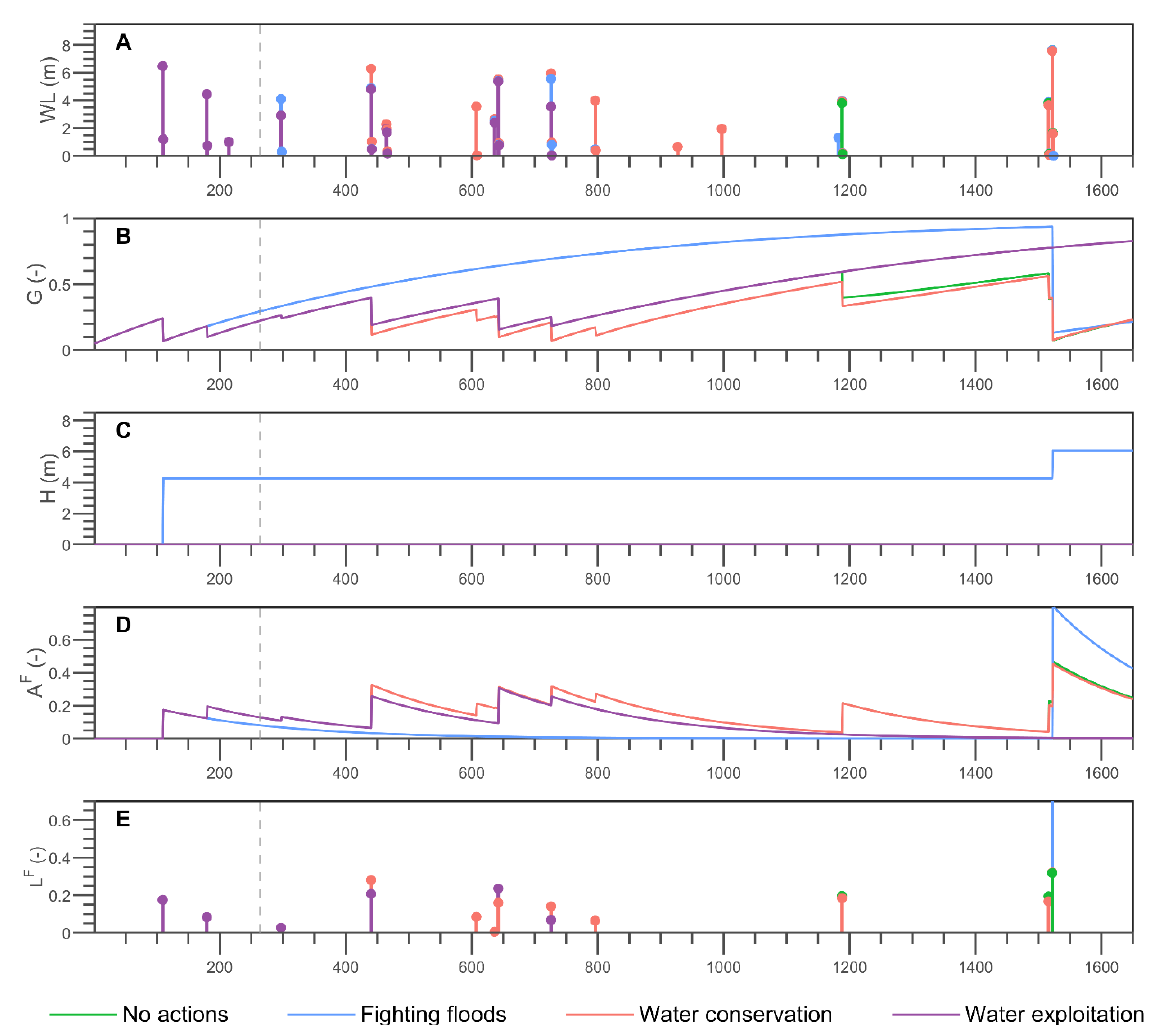
Figure A16. Flooding-based variables of the synthetic experiments additional scenario #4 considering dam construction and human-flood interactions with the four water management strategies introduced in this study. (A) Water level (WL), (B) proportion of population in floodplain (G), (C) levee height (H), (D) flood awareness (AF), and (E) flood losses (LF). The grey dashed line indicates the construction of the Wivenhoe